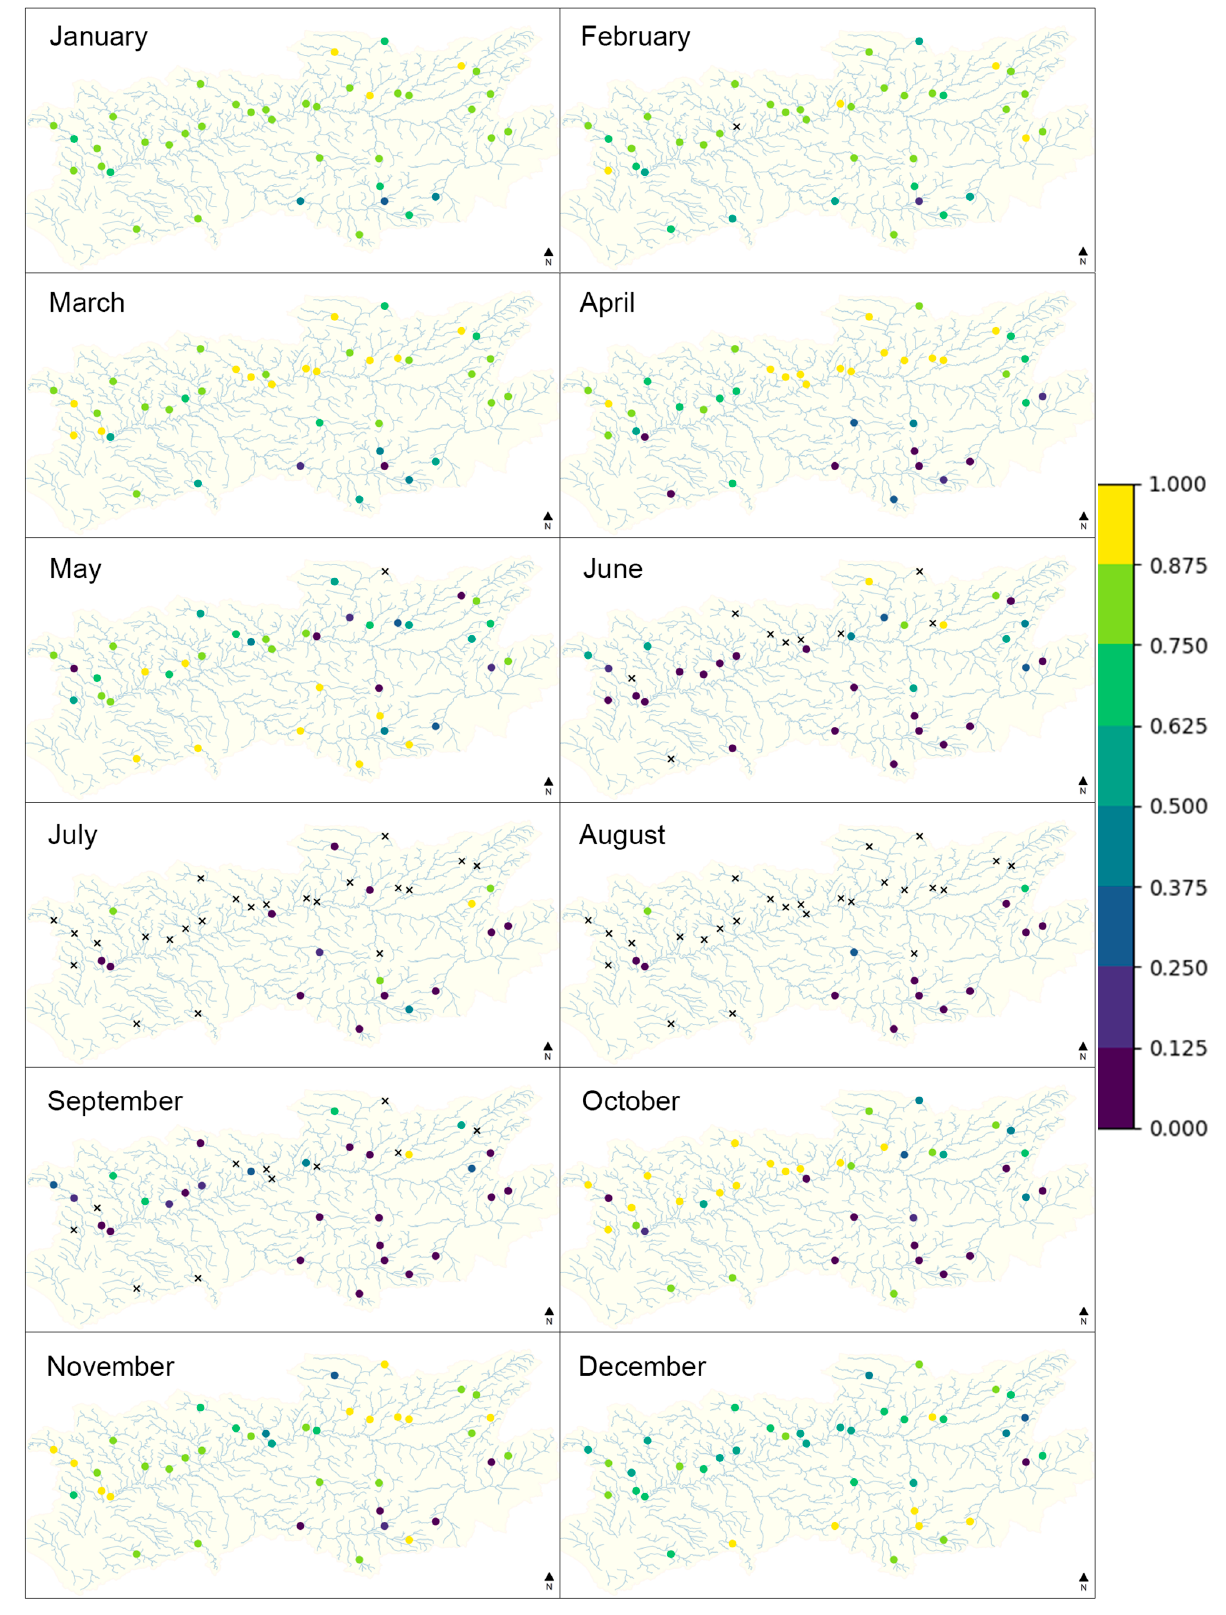
Figure 9. PC-1 loadings for the monthly series. Crossed stations indicate insufficient data for that monthly analysis.